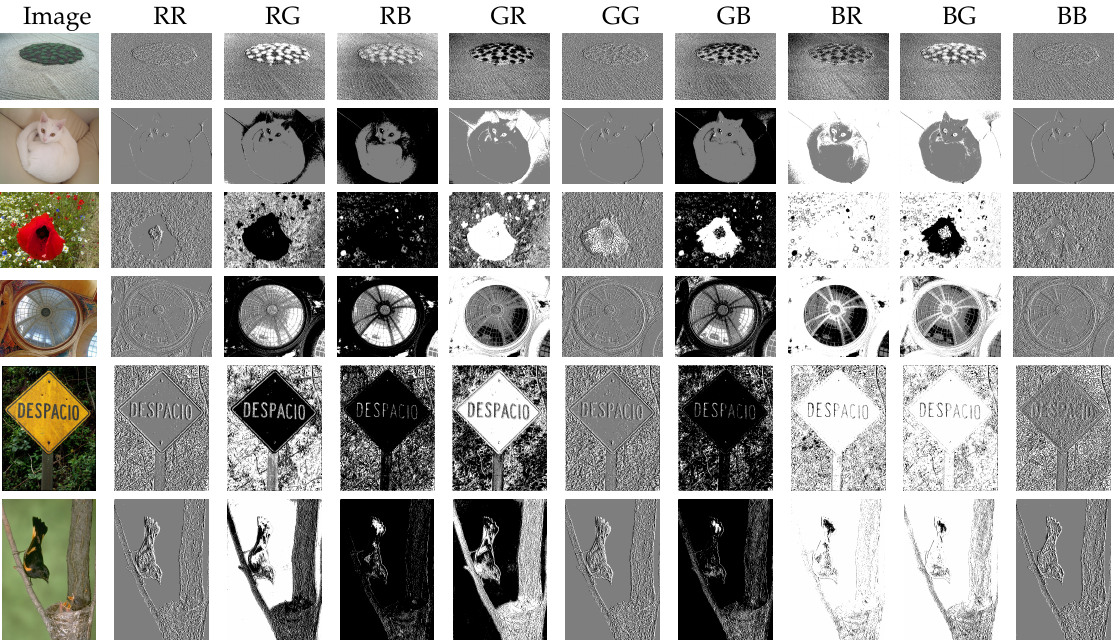
Figure 1. Micro-texture maps given by LTP on the 9 opposing color pairs (for the RGB color space). We can notice that this LTP coding already highlights the salient objects.